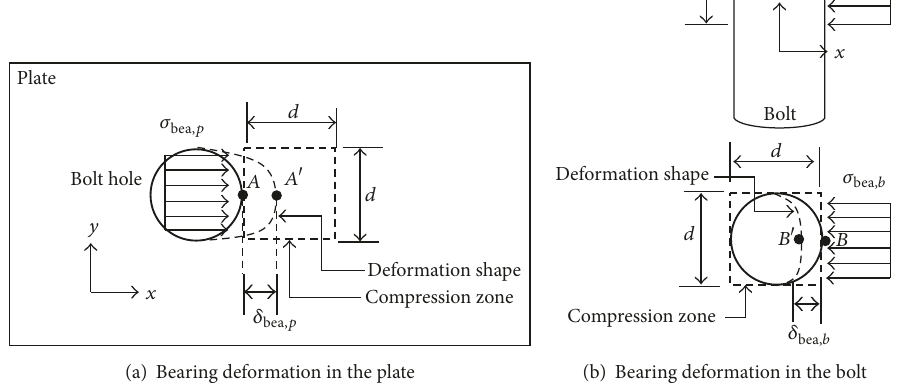
Figure 16: Schematic diagram of bearing deformation in the plate and bolt.